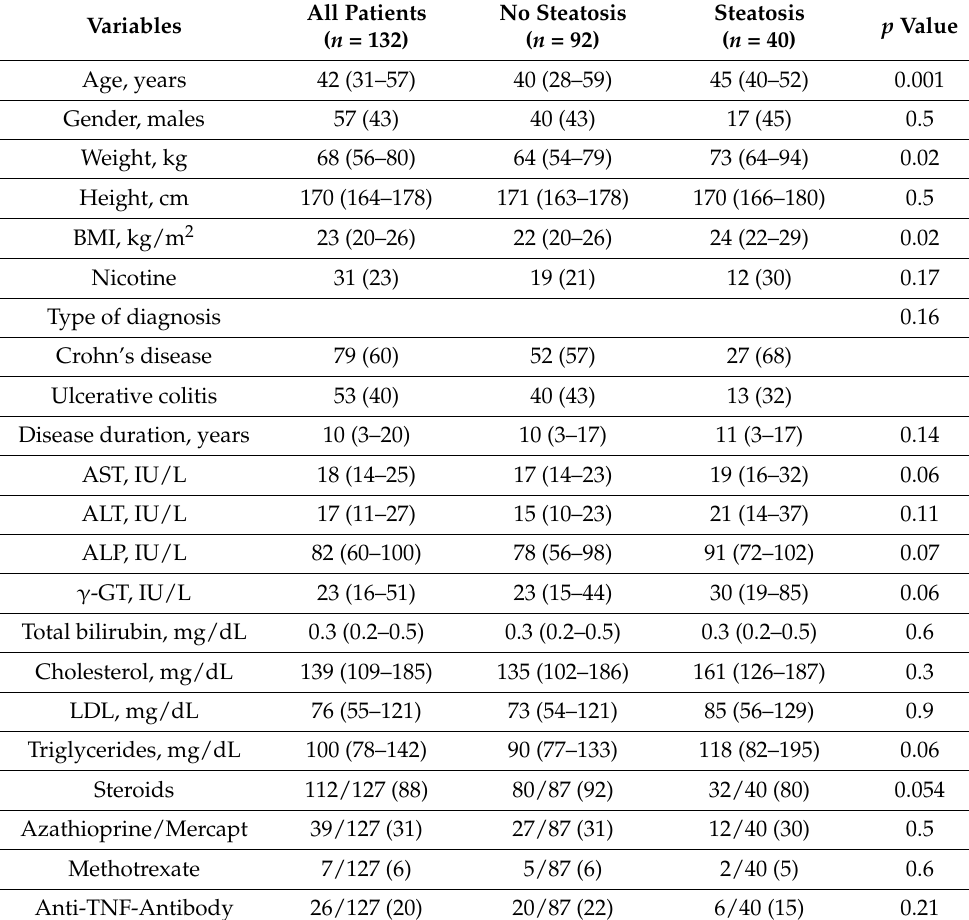
Table 1. Patient characteristics.